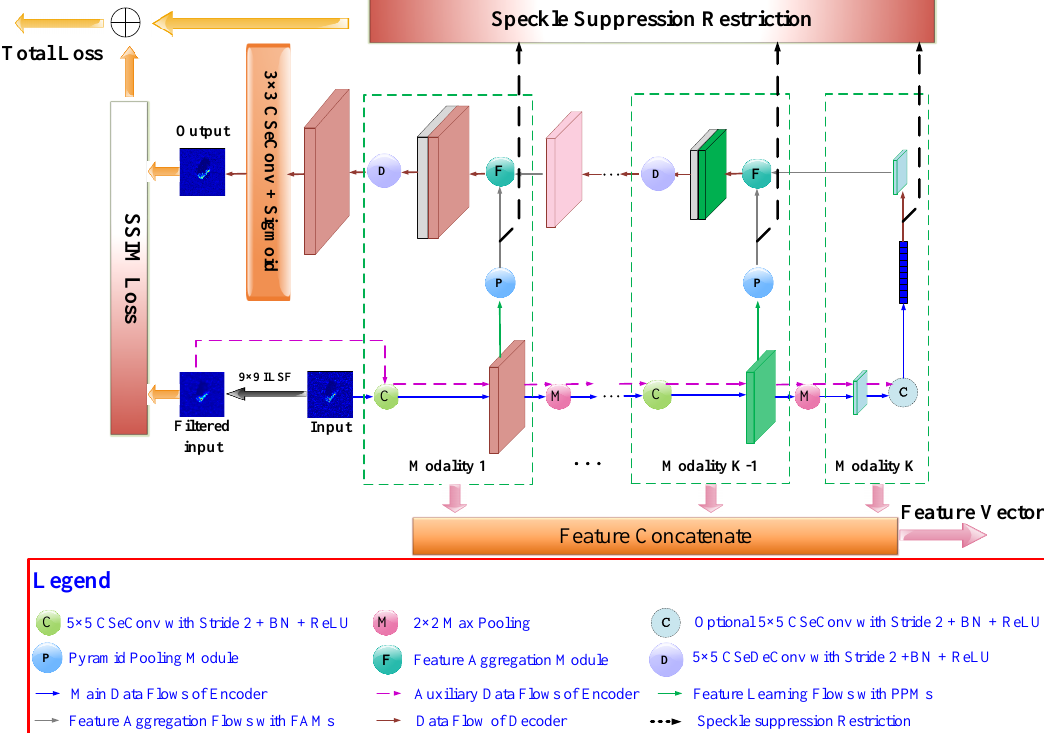
Figure 1. The overall architecture of the U-shaped multi-scale convolution auto-encoder. The feature vector learnt at each modality level will be converted into vector and concatenated to form the feature vector for SAR ATR. CSeConv stands for the compact depth-wise separable convolution layer; BN stands for batch normalization; ReLU stands for the rectified linear unit activation function; CSeDeConv denotes the compact separable deconvolution layer; PPM stands for the pyramid pooling modul; FAM stands for the feature aggregation module; ILSF refers to the improved Lee sigma filter; SSIM refers to the structural similarity index